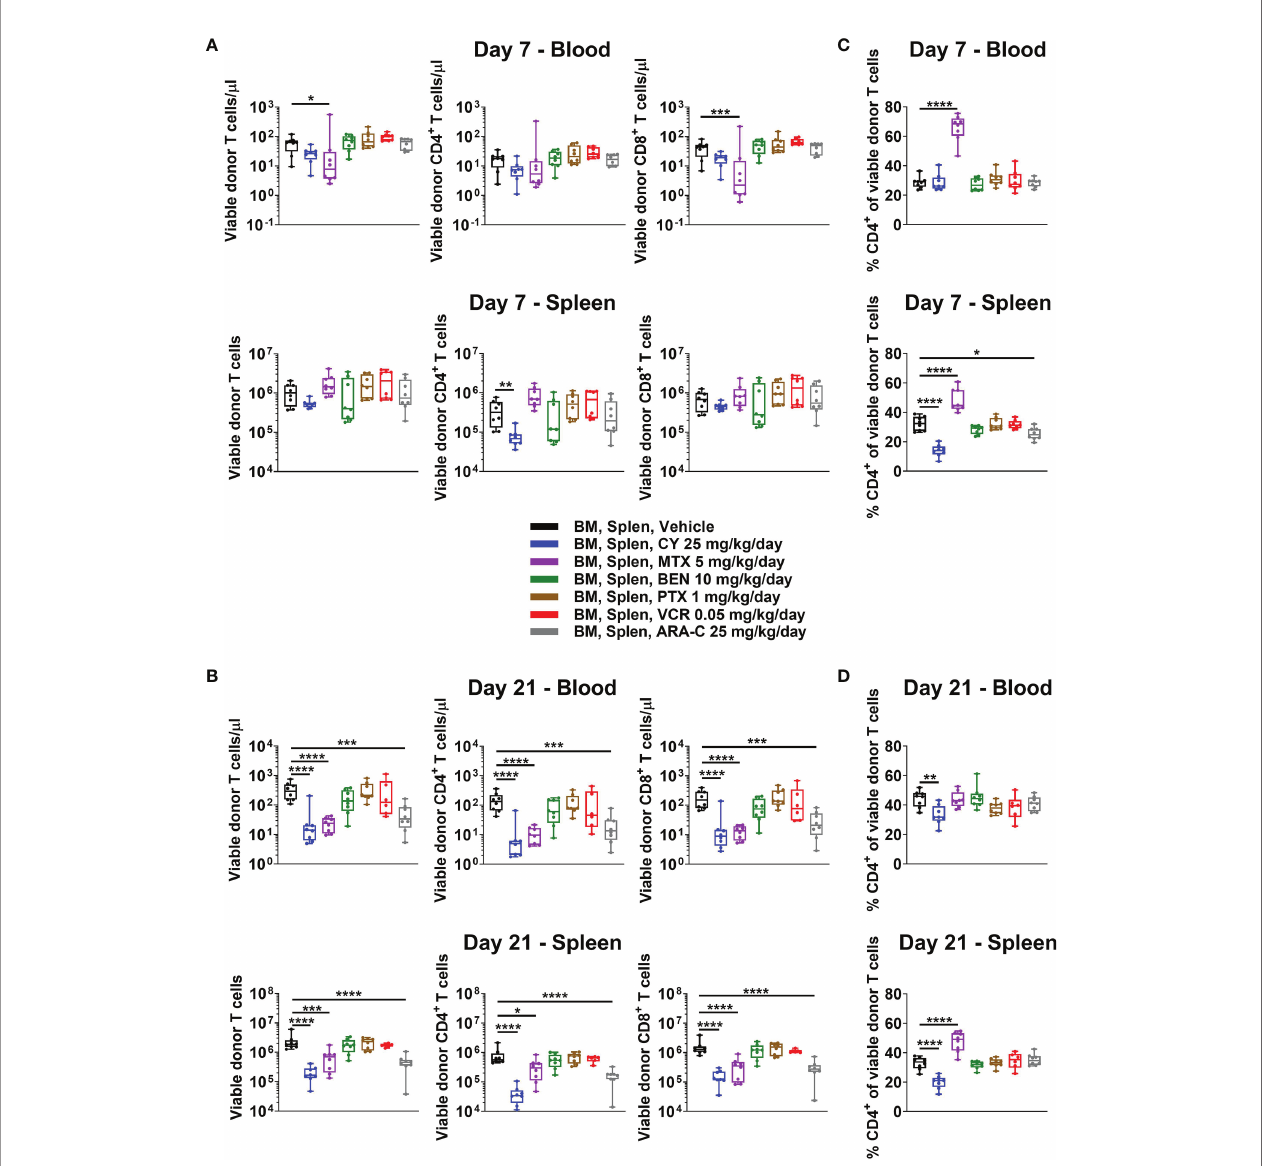
FIGURE 3 | All partially effective chemotherapeutics constrain T-cell recovery at day +21, but MTX and CY differentially affect the balance of CD4 + versus CD8 + T cells, distinct from all other chemotherapeutics. Mice were transplanted as in Figure 1 and received intraperitoneal injections on days +3 and +4 with either PBS vehicle or the optimal dose of one of the chemotherapeutics of interest. At day +7 or +21, mice were euthanized, and their blood and spleens were assessed by fl ow cytometry. (A) Total numbers of CD3 + T cells and CD4 + and CD8 + T-cell subsets were not signi fi cantly reduced in BEN-, PTX-, VCR-, or ARA-C-treated mice at day +7. However, MTX signi fi cantly reduced total number of CD3 + and CD8 + T cells in the blood, while CY signi fi cantly reduced total numbers of CD4 + T cells in spleens at day +7. (B) At day +21, CY, MTX, and ARA-C all constrained recovery of CD4 + and CD8 + T-cell subsets. (C, D) MTX and CY had opposite effects at both (C) day +7 and (D) day +21 on the balance of CD4 + and CD8 + T cells, divergent from effects seen in vehicle-treated mice and mice treated with other chemotherapeutics. Combined results from two independent experiments are shown with n = 4/group/experiment except for VCR at day +21 (n = 6 total) due to excess early deaths in one experiment prior to day +21. *p < 0.05, **p < 0.01, ***p < 0.001, ****p < 0.0001 on one-way ANOVA followed by the Holm-Sidak post hoc test using the vehicle-treated group as the control. Only signi fi cant results are shown; all other comparisons between treatment groups and the vehicle group are non-signi fi